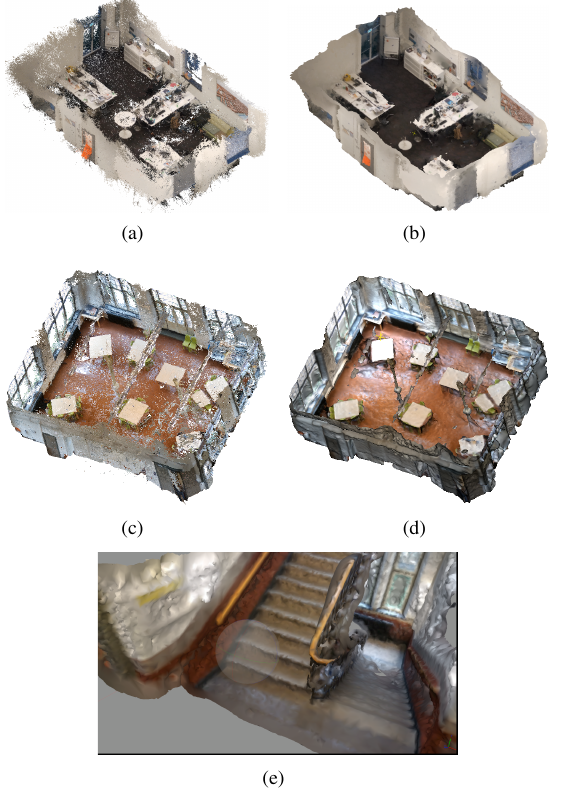
Figure 10. (a) and (b) are point cloud and mesh of the office of the 3D Geoinformation Research Group separately. (c) and (d) are point cloud and mesh of the TU Delft Science Centre Workshop 5. (e) is the mesh of stairwell.